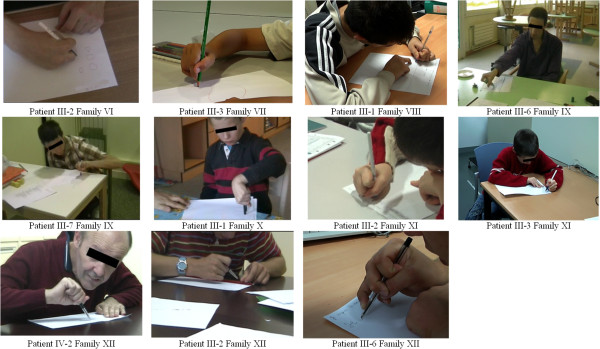
Significant interaction between the factor ‘group’ and the within factor ‘effector’ (fingers vs limb) on the De Renzi scale:
ARX
patients were much more impaired on independent fingers movements than on global limb movements (*p < 0.05; ****p < 0.0001).